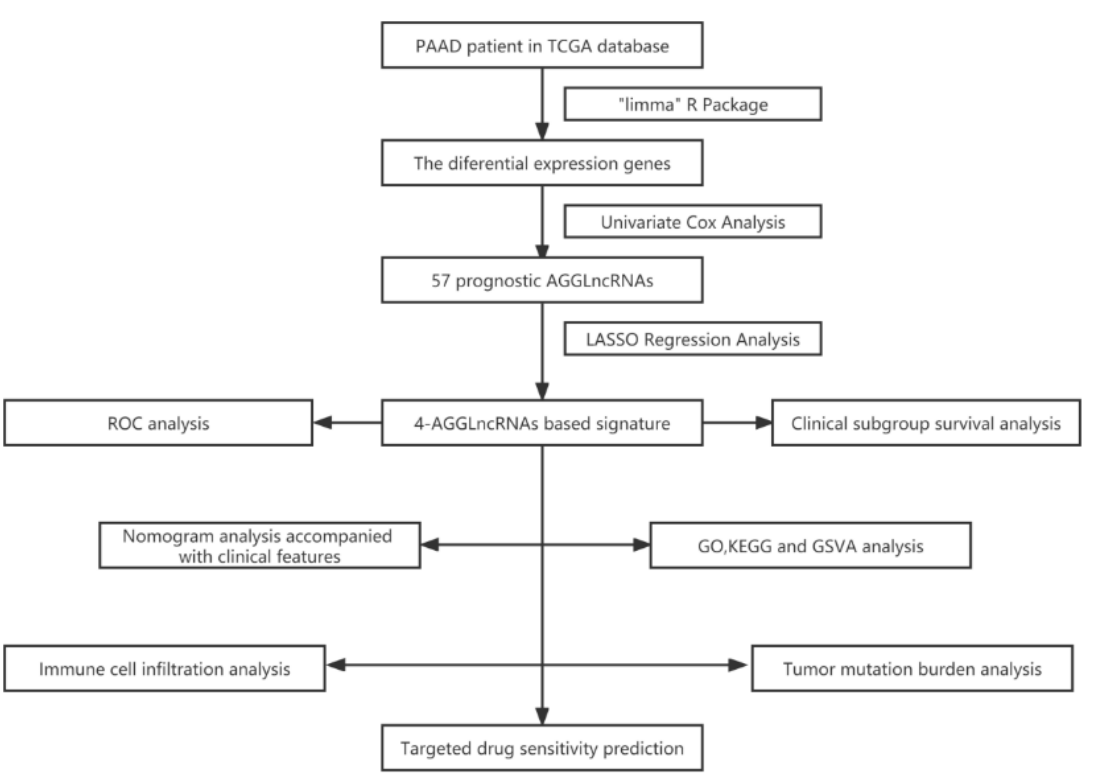
Figure 1. The flowchart shows the design concept of this study.